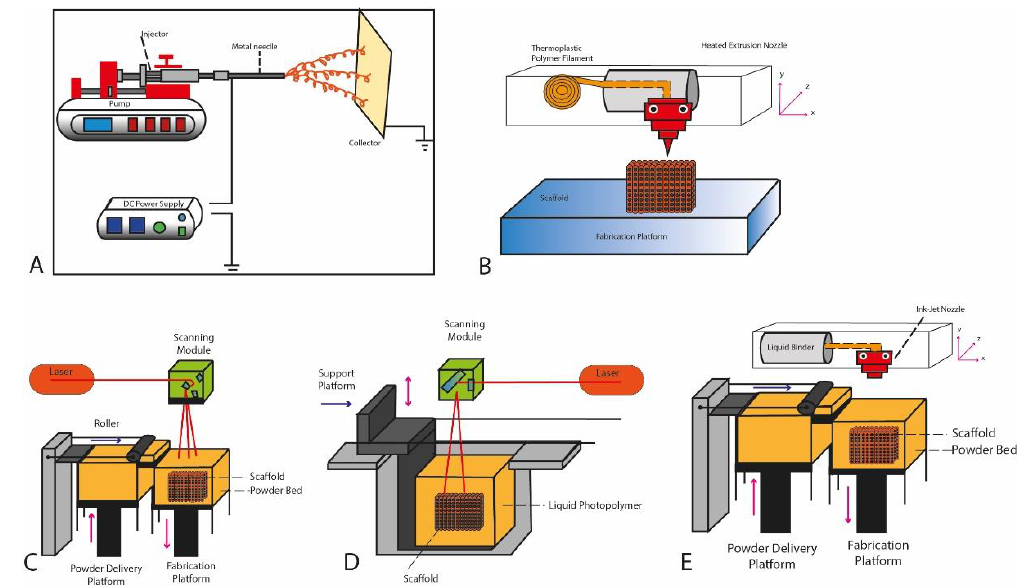
Figure 1. Diagram of the different 3D printing techniques. ( A ) Electrospinning. ( B ) Extrusion. ( C ) Power Bed Fusion. ( D ) Stereolithography. ( E ) Inkjet printing.